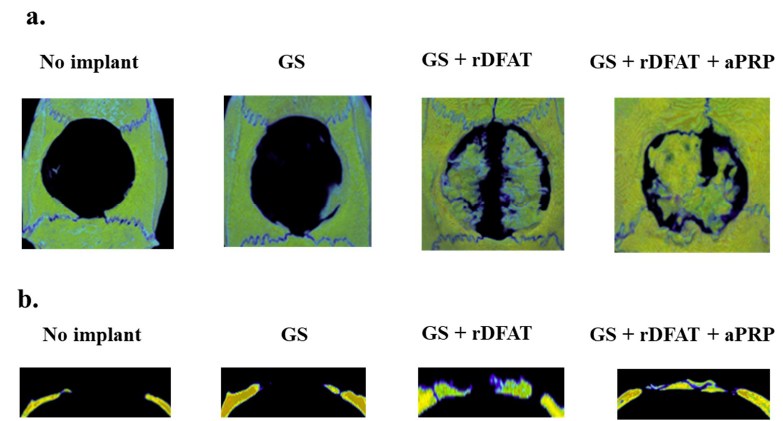
Figure 11. Micro‐computed tomography analysis and microscopic images of the defects. Figure 11. Micro-computed tomography analysis and microscopic images of the defects. Representative macroscopic images of the defects treated with sponges after implantation surgery at 4 weeks. ( a , b )